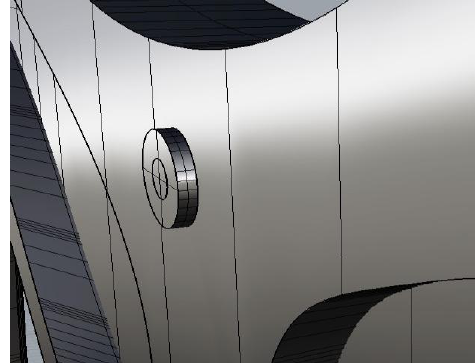
Figure 12. Redesigned structure.